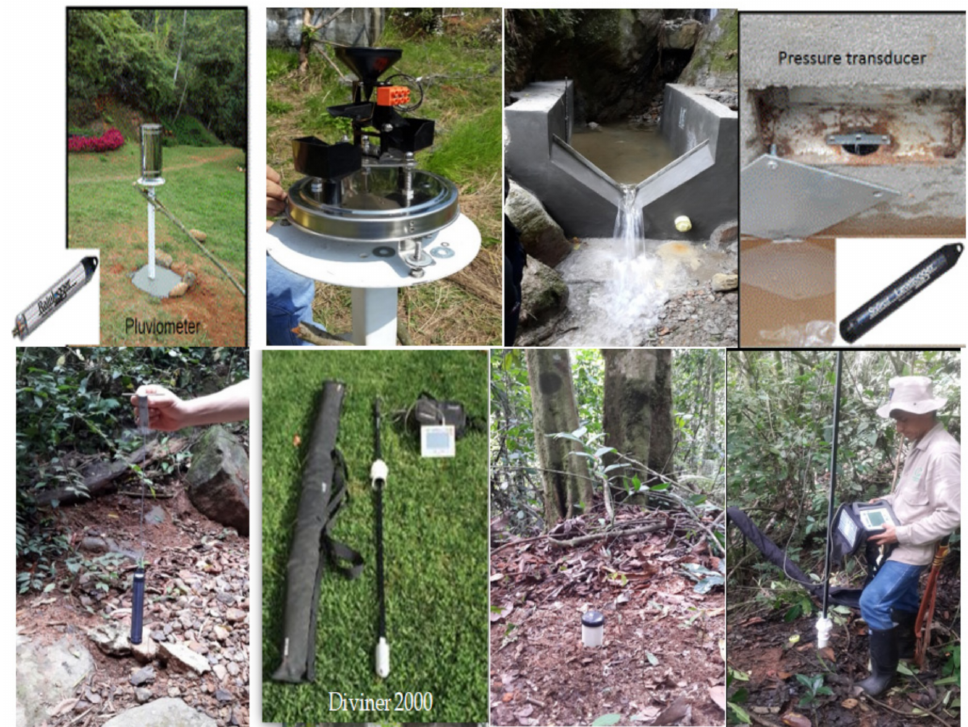
Figure 2. Main experimental equipment and instruments: tipping bucket and rain logger pluviome- ters, wall V-Weir with liminimeter and Levelogger; soil moisture monitoring solution, humidity site-tube and operator measuring the soil